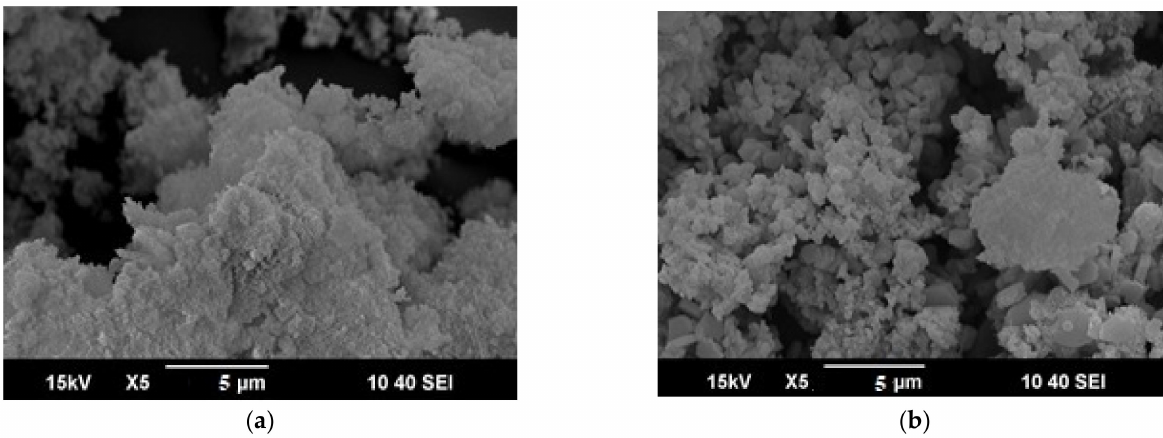
Figure 1. SEM images ( a ) COC-AC; ( b )